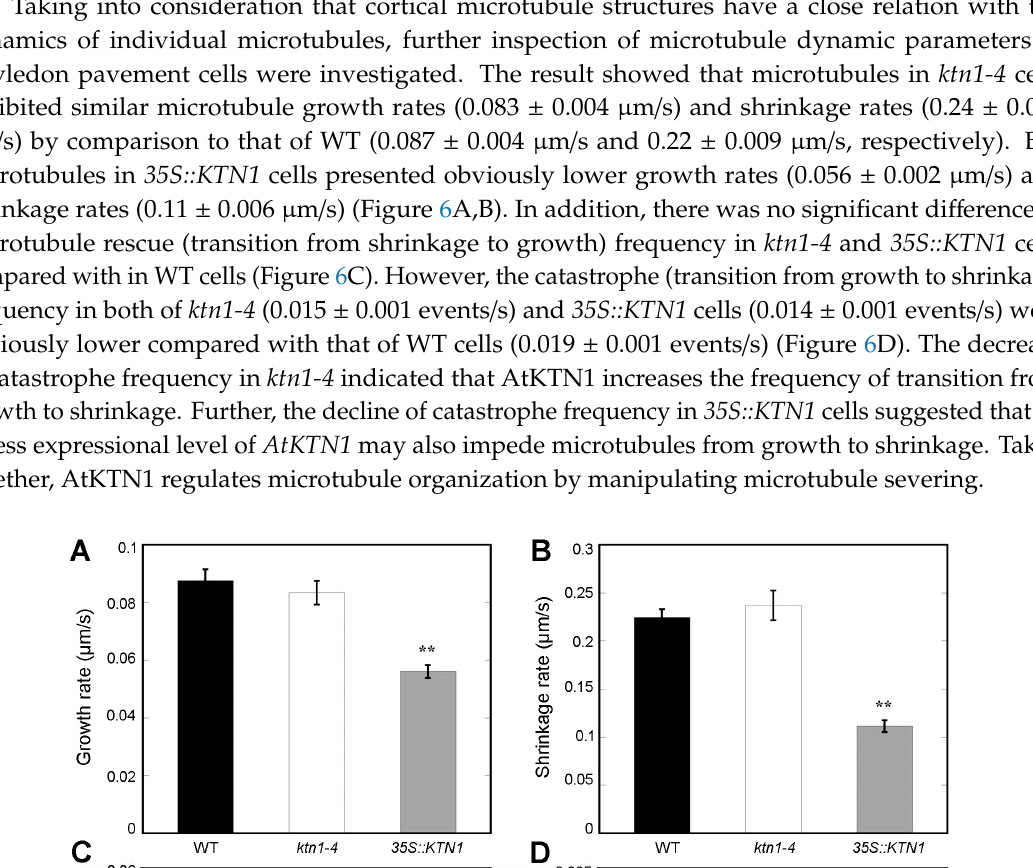
Figure 6. Dynamic parameters of single microtubules in cotyledon pavement cells. Quantification of microtubule growth rates ( A ), shrinkage rates ( B ), rescue frequencies ( C ) and catastrophe frequencies ( D ) in WT (Col-0), ktn1-4 and 35S::KTN1 cells. More than 38 microtubules for each type of cells were selected to measure parameters associated with single microtubule dynamics. Error bars indicate SE. * P < 0.05 and ** P < 0.01 by a Student’s t test.